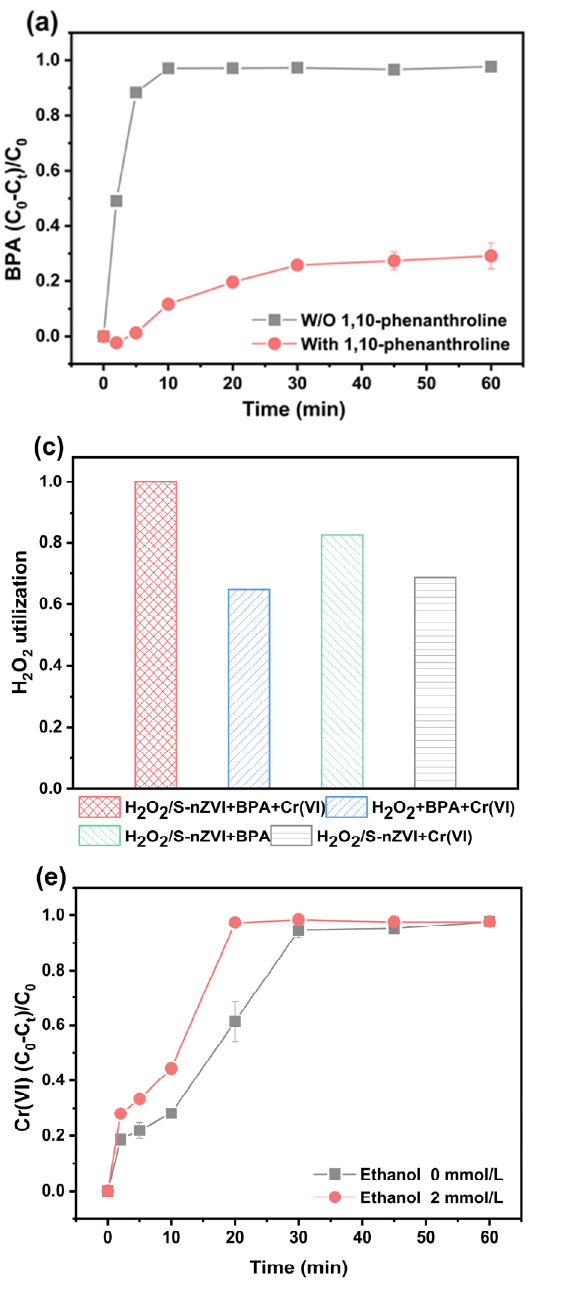
Figure 3. The synchronous removal of ( a ) BPA and ( b ) Cr(VI) by S ‐ nZVI/H 2 O 2 with/without the presence of o ‐ phenanthroline; ( c ) the use rate of hydrogen peroxide in different systems; the synchronous removal of ( d ) BPA, and ( e ) Cr(VI) by S ‐ nZVI/H 2 O 2 with/without the presence of ethanol; ( f ) the concentration of Cr species in the solution.